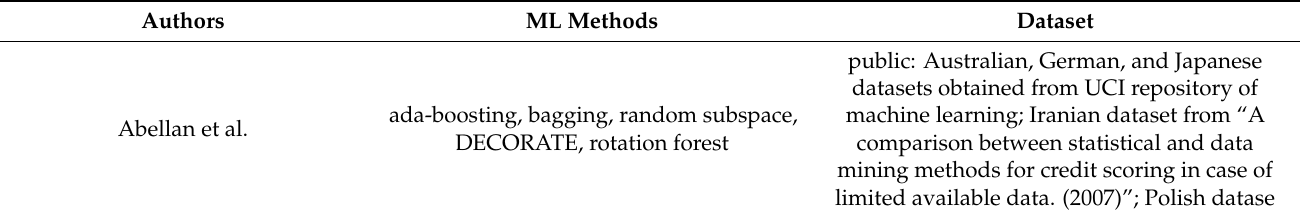
Table 4. Machine learning methods applied in each paper and the respective dataset, referenced by authors.